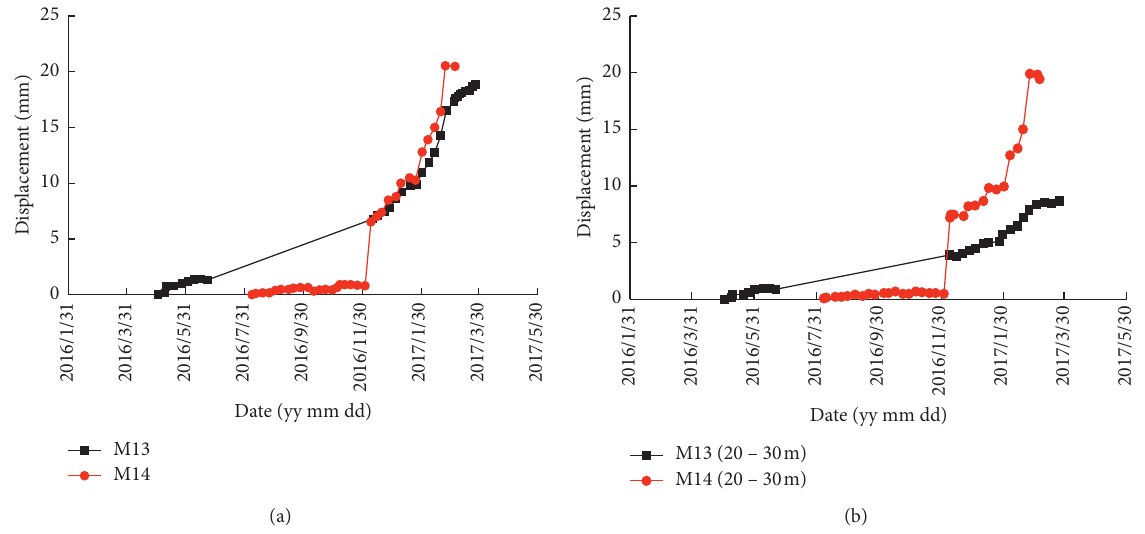
Figure 15: Evolution characteristics of upper surface and deep deformation at the middle of slope. (a) Variation of surface deformation at the middle of slope with time. (b) Variation of deep deformation at the middle of slope with